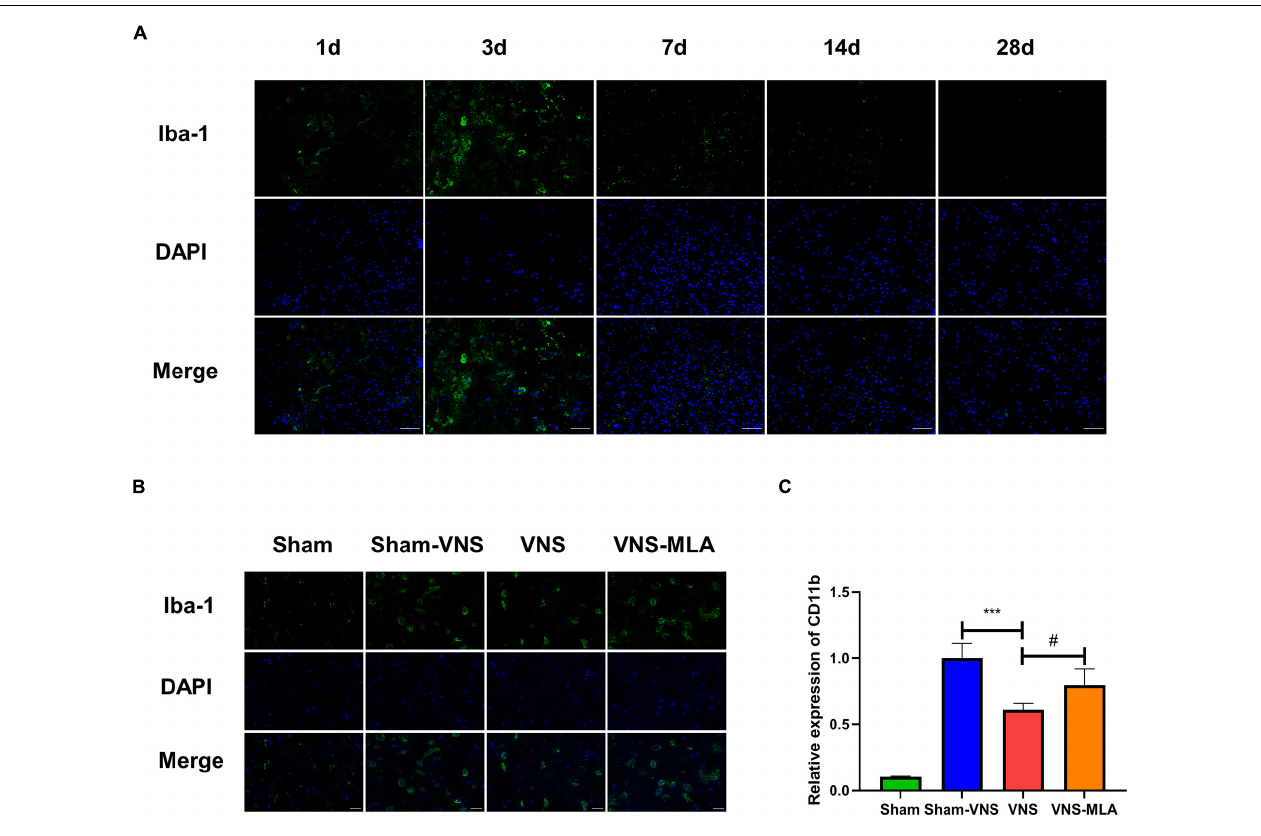
FIGURE 3 | Vagus nerve stimulation (VNS) reduced microglial activation. (A) Immunofluorescence staining showed the amounts of microglia in spinal cord tissues at different time points, scale bar = 50 µ m. (B) Iba-1 staining in microglia in the spinal cord sections on day 3 after spinal cord injury (SCI). Activated microglia exhibited significant cellular hypertrophy and retraction of processes after SCI, while resting microglia displayed smaller somata and processes, scale bar = 20 µ m. (C) Quantitative reverse transcription-polymerase chain reaction (qRT-PCR) demonstrated the gene levels of CD11b in the spinal cord of different groups on day 3 after SCI. n = 4 per group, *** P < 0.001 VNS vs. Sham-VNS group. # P < 0.05 VNS vs. VNS-MLA